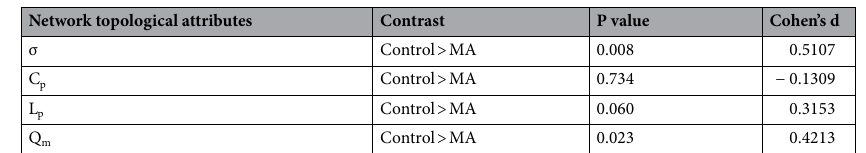
Table 2. Global topological attributes of brain WM structural networks in the methamphetamine (MA)- dependent patients (MA) and the normal controls (Control). σ = small-wordness; C p = weighted clustering- coefficient; L p = weighted characteristic path length; Q m = weighted modularity. Cohen’s d indicates the value of effect size. The small, medium and large levels of the effect size are 0.2, 0.5 and 0.8, respectively, according to Cohen’s definition.